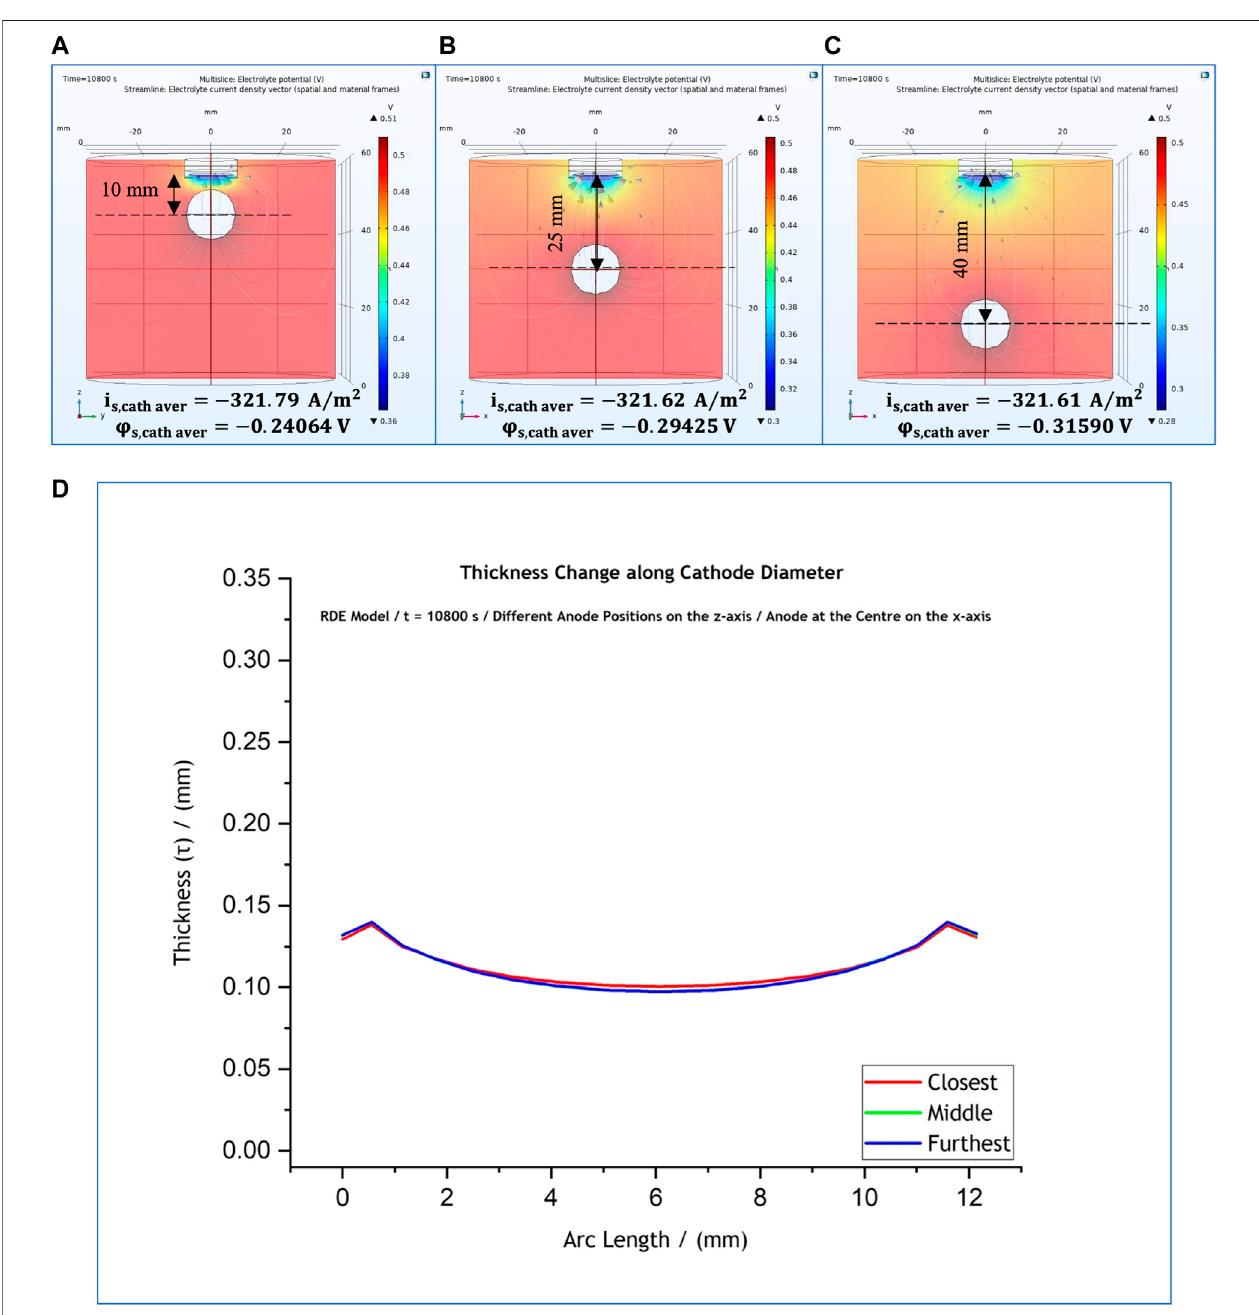
FIGURE 8 | (A – C) Variations of anode position along z -axis, with a fi xed x -axis position at the centre of the cell. (D) Effect of anode position on the predicted thickness pro fi le for anode position at 10 mm (red); 25 mm (green); and 40 mm (blue).